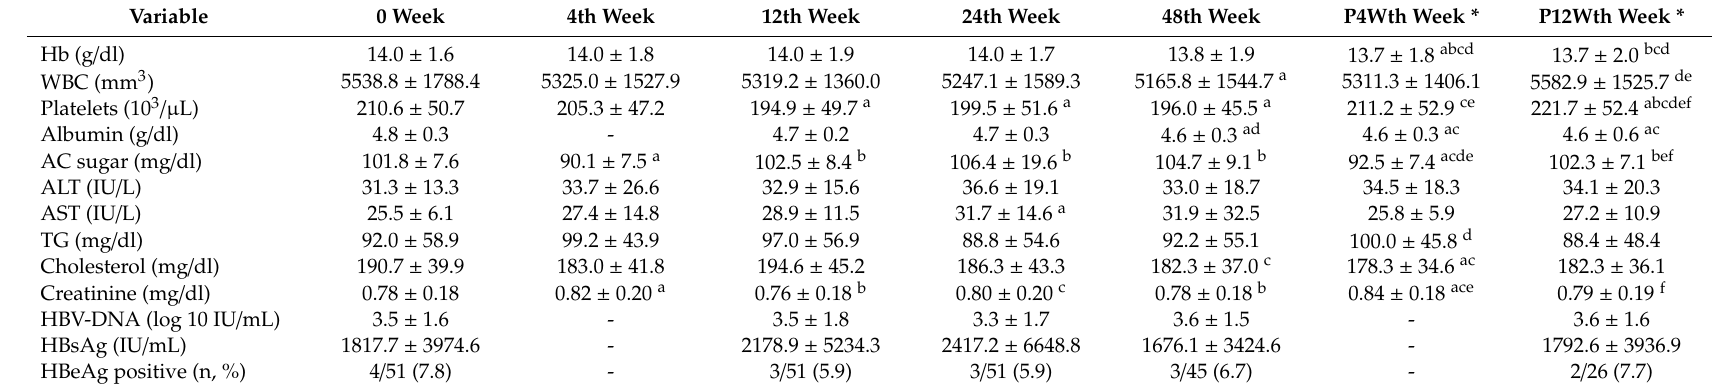
Table 2. Between biochemistry and before and after fucoidan supplementation in chronic hepatitis B